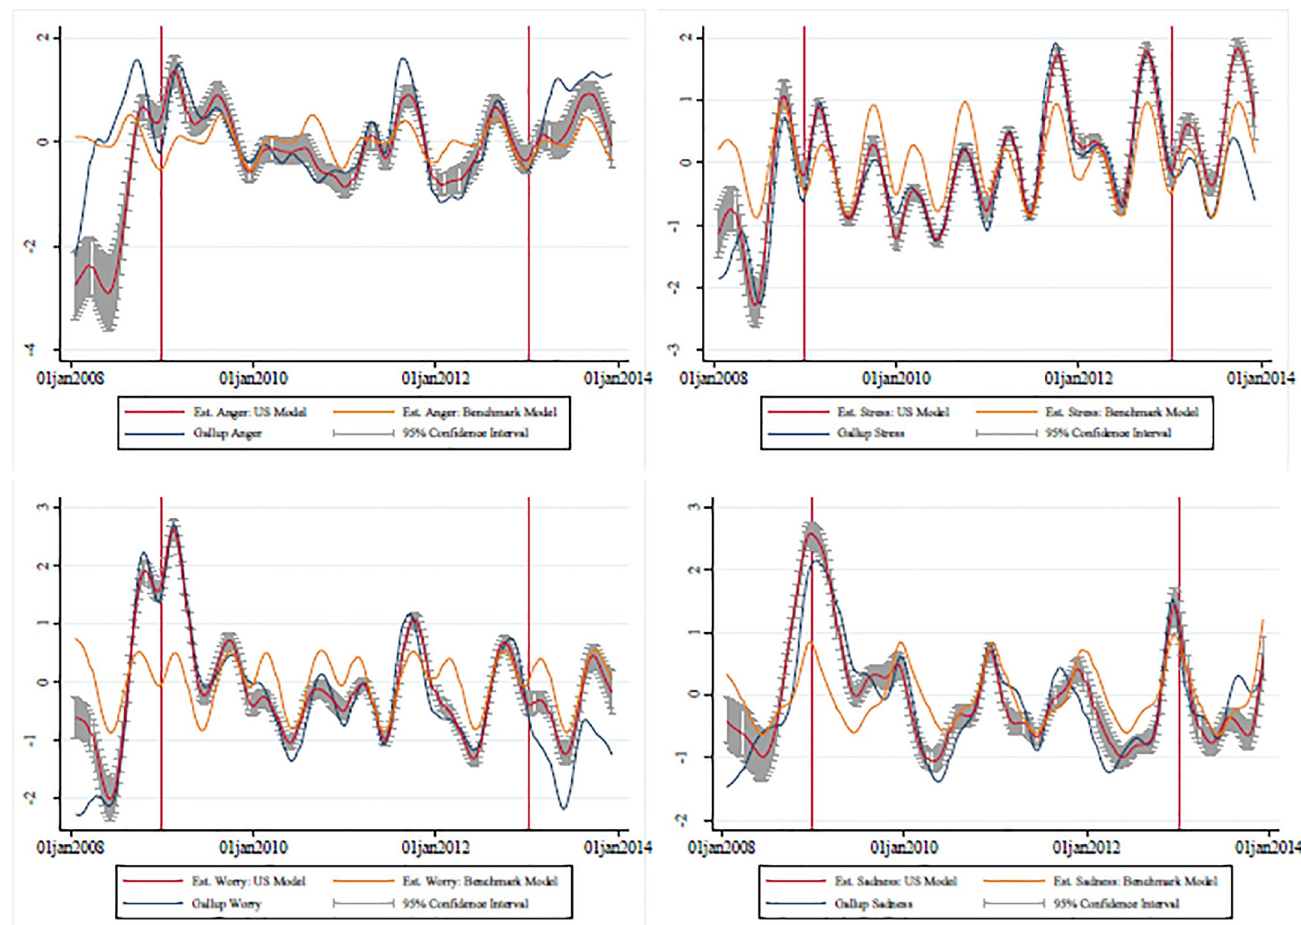
Fig 2. Predicted and observed subjective well-being (united states aggregate level). Graphs show the estimates (with confidence intervals) for subjective well- being at the US level, constructed using the US-model, in red, alongside estimates from the benchmark (seasonality only) model in yellow and the Gallup series in blue. Confidence intervals are constructed using 1000 draws. Training data is inside the red lines, and Testing data is outside the red lines. Correlations are given in Table 6.